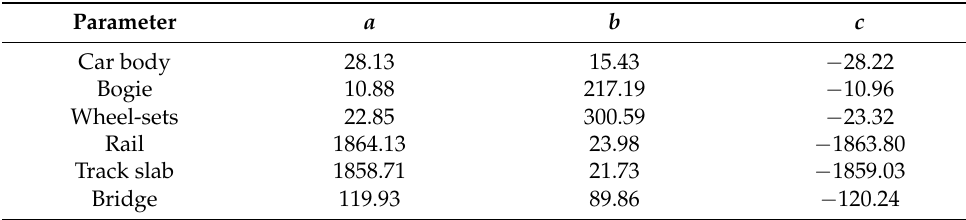
Table 4. The Value of Parameters for the